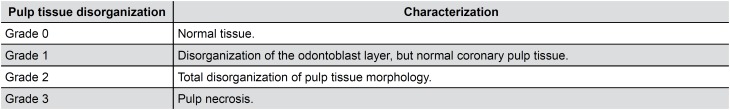
Classification of pulp tissue disorganization